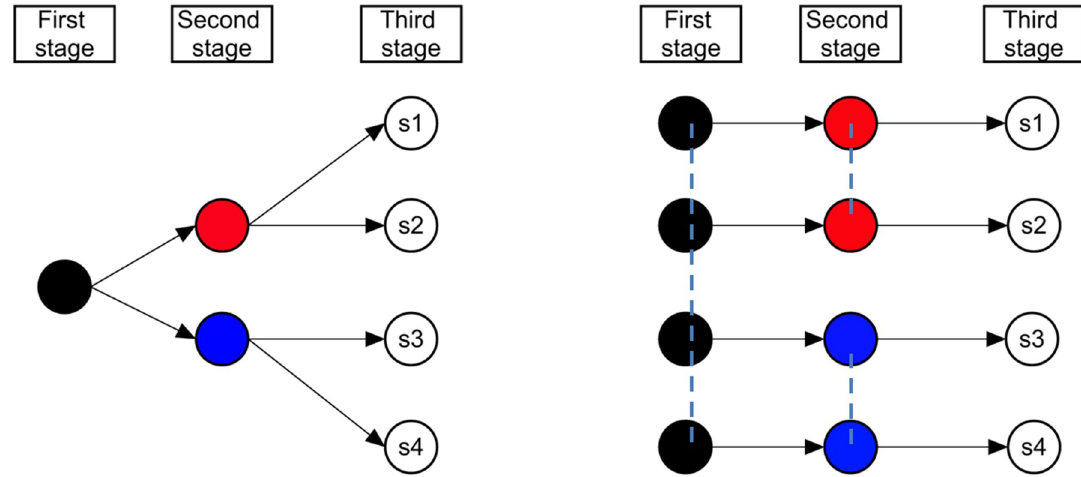
Fig 2. Decision tree example with two periods, three stages, and four